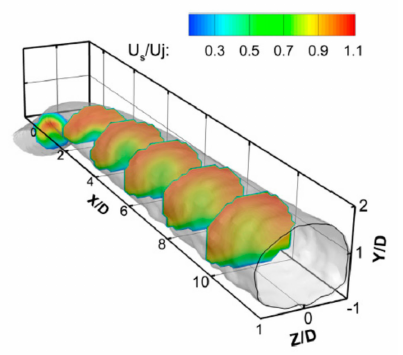
Figure 15. Iso–surface of 5% concentration, with cross-sections perpendicular to the jet centerline (color-coded by jet velocity)